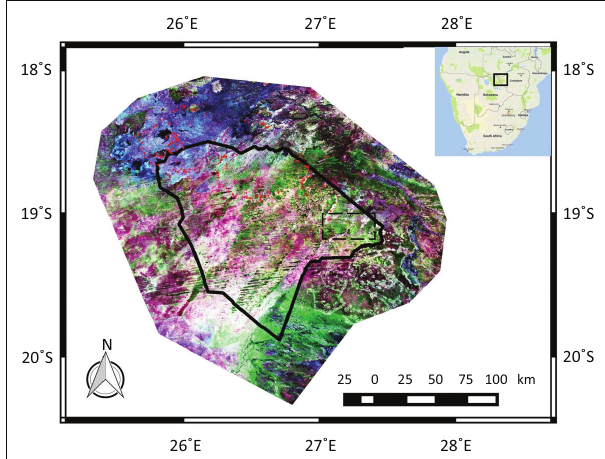
FIGURE 1: Study area with Hwange National Park boundary (continuous black line) and the park’s location in southern Africa. Dashed black line within Hwange National Park limits outlines area shown in Figure 6. Underlying image is a mid- dry season Landsat 8 Operational Land Imager